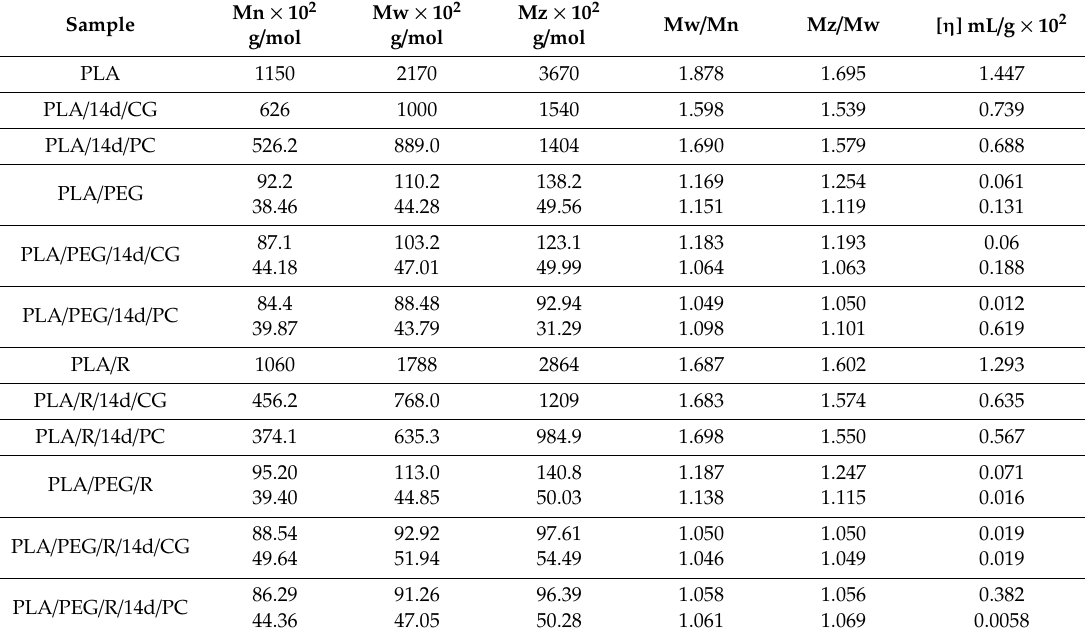
Table 3. Average number (Mn), weight (Mw) and Z average (Mz) molecular weight, polydispersity (Mw / Mn, Mz / Mw) and intrinsic viscosity [ η ] of the PLA-based samples before and after 14 days of fungal degradation.